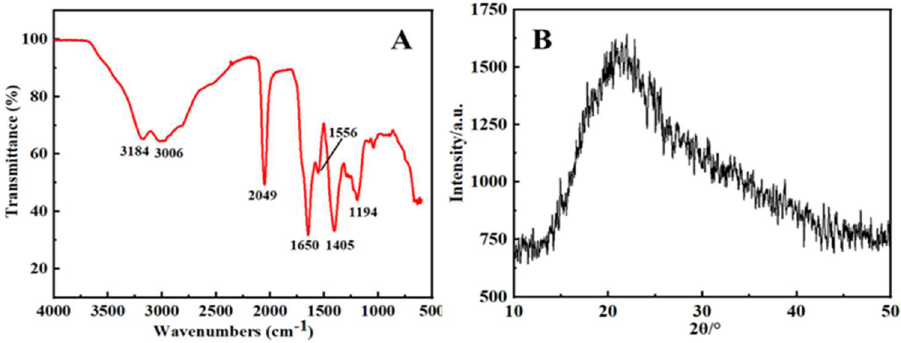
Figure 2. ( A ) FTIR spectrum of S, N−CQDs; ( B ) XRD pattern of S, N−CQDs.